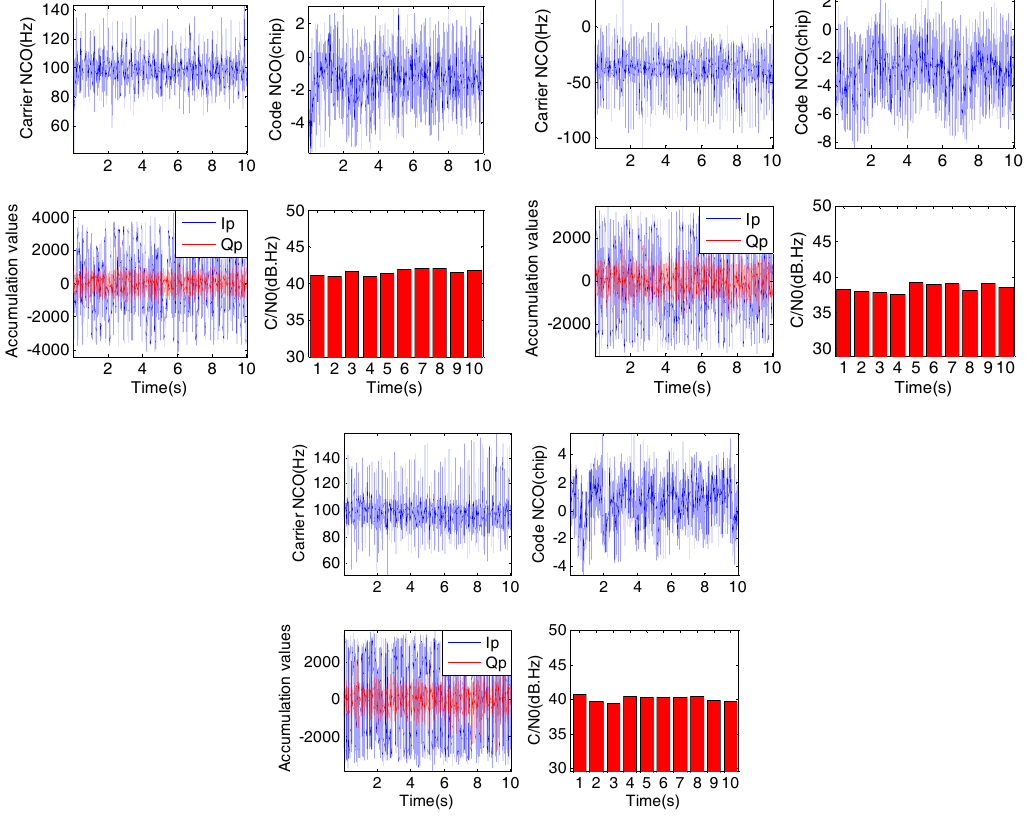
Figure 21. Carrier and code tracking results of different spin rates of 3.8 r/s (top left group), 6.4 r/s (top right group), and 7.5 r/s (bottom group).